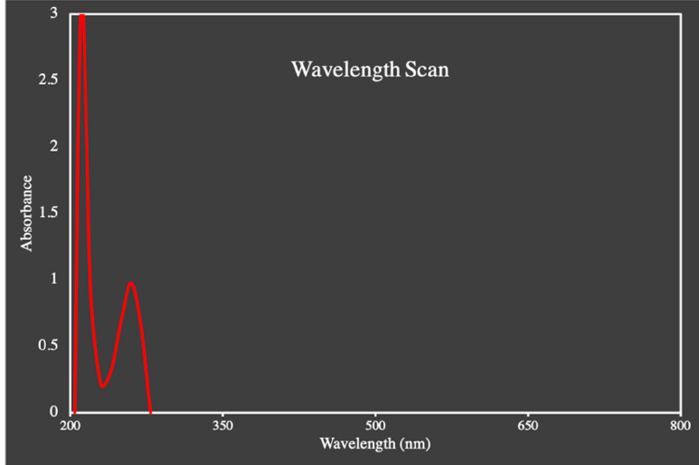
Figure 3. The absorption spectra of TAF.